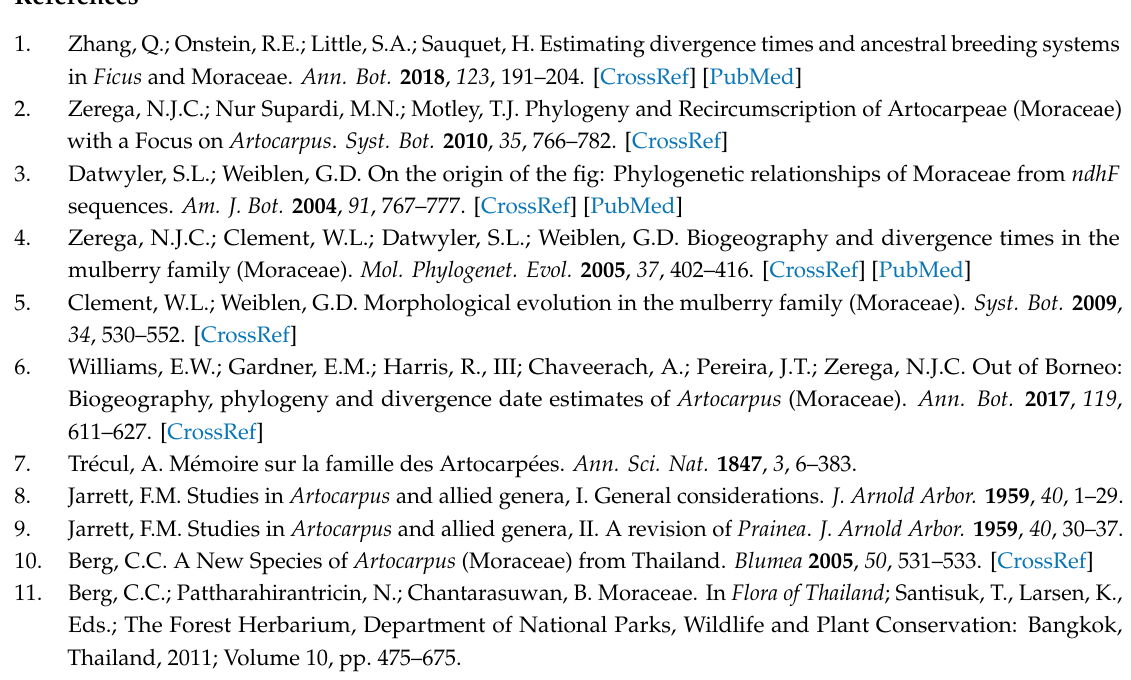
Figure S27: Four combined regions maximum parsimony (without branches collapsed) tree of A. lacucha and A. thailandicus with other Artocarpus species. A. integer and A. heterophyllus were chosen as an outgroup, Figure S28: Four combined regions maximum likelihood (without branches collapsed) tree of A. lacucha and A. thailandicus with other Artocarpus species. A. integer and A. heterophyllus were chosen as an outgroup, Supplementary file S1: Four loci multiple